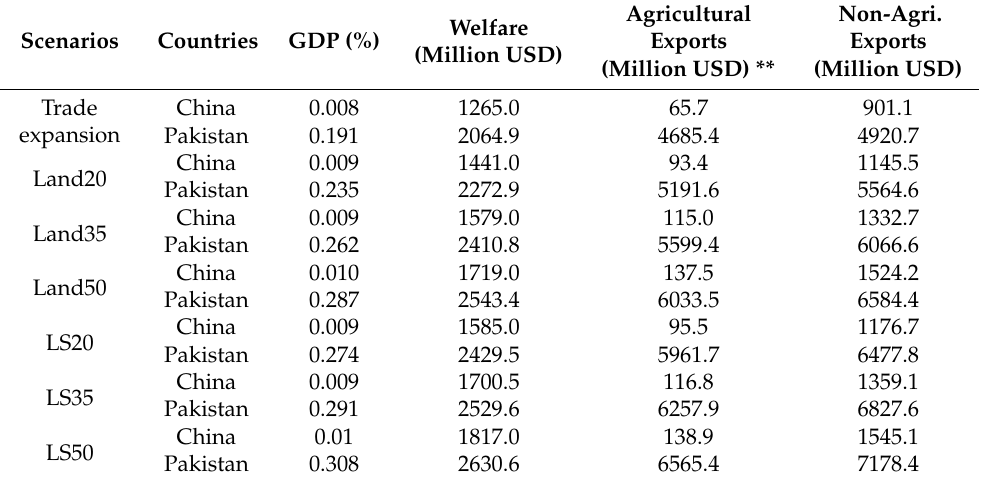
Table 3. Effects on Macroeconomic Indicators